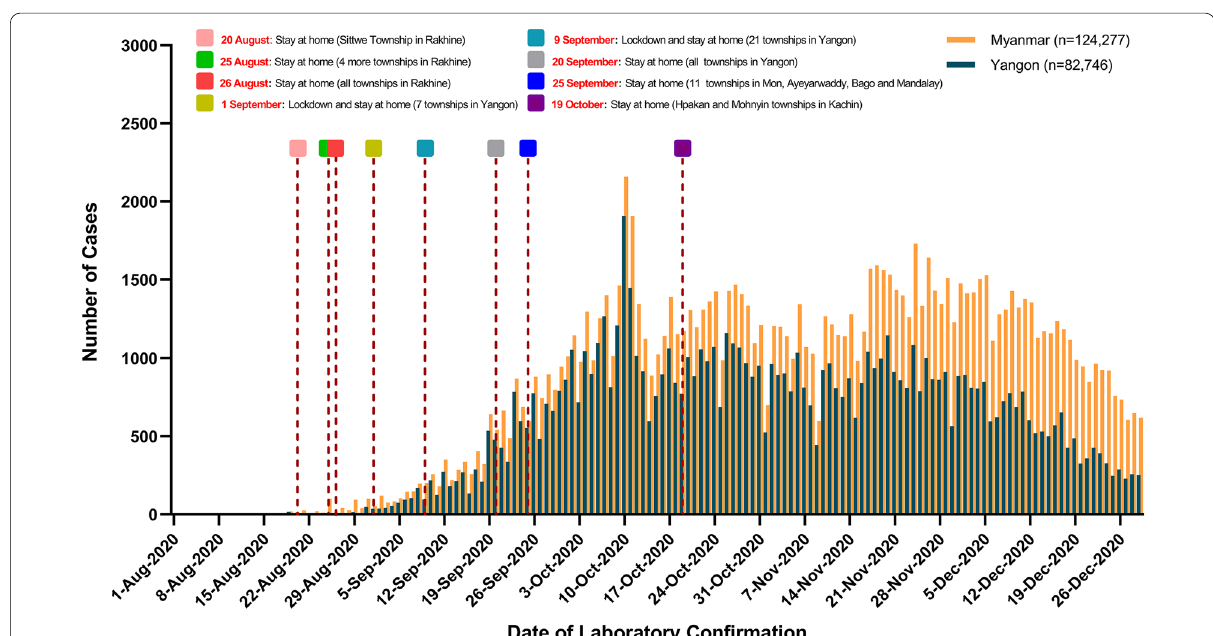
Fig. 1 Daily confirmed COVID-19 cases in Myanmar and Yangon Region from August to December, 2020. The orange and blue bars represent the daily confirmed COVID-19 cases in Myanmar and Yangon Region, respectively. The dates of NPIs during second wave of epidemic are shown in different colors of rectangles. The total confirmed cases are 124,277 in Myanmar and 82,746 in Yangon Region from 1st August to 31st December